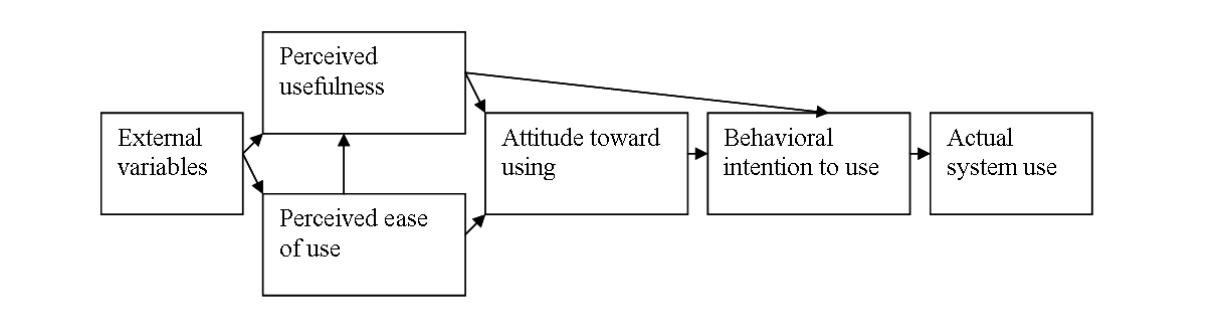
Figure 1. Technology acceptance